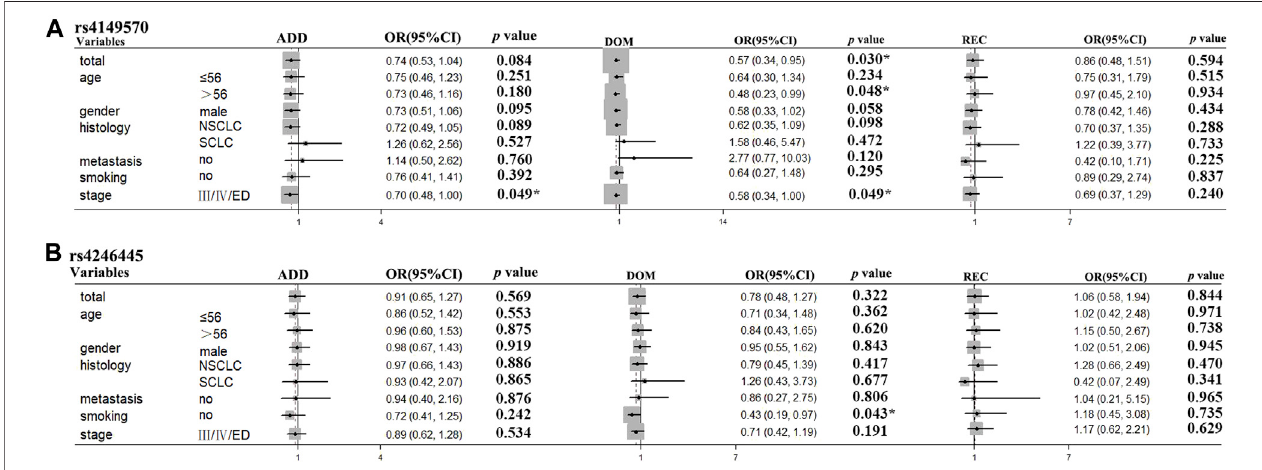
FIGURE 3 | TNFRSF1A rs4149570 and FASN rs4246445 polymorphisms were signi fi cantly associated with survival times in the subgroups of patients with lung cancertreated withplatinum-basedchemotherapy. (A) TNFRSF1A rs4149570polymorphismwassigni fi cantly associated withOStime inpatientsless than55